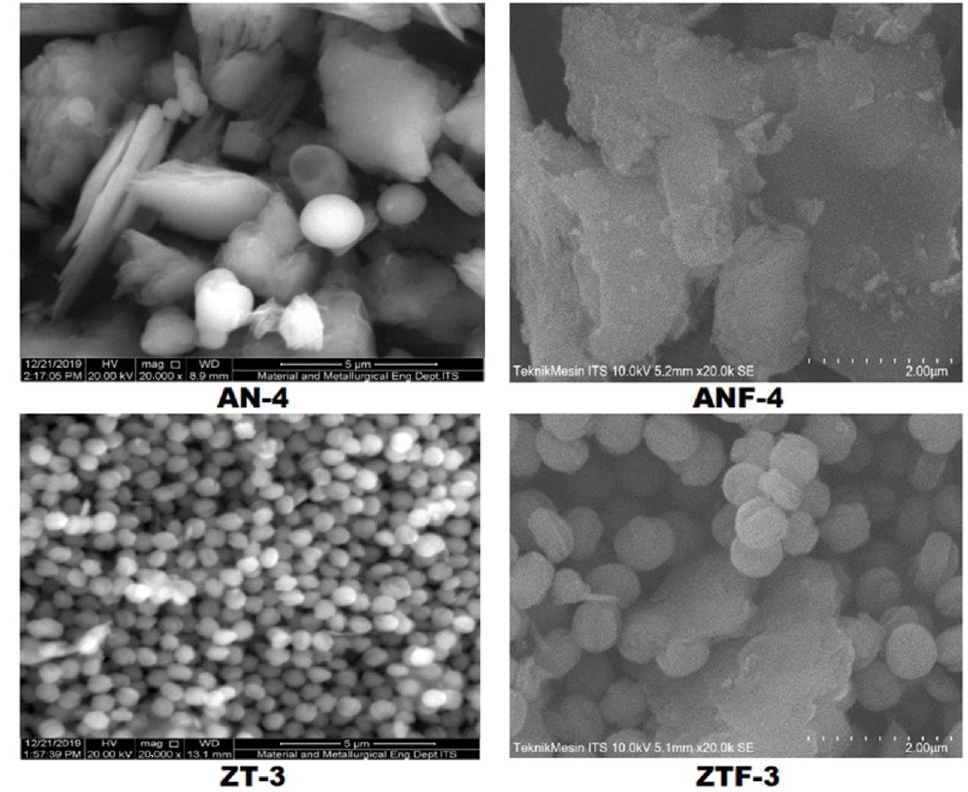
Figure 7. SEM images of aluminosilicates and ZSM-5 before and after Fe 3+ addition. The presence of amorphous materials can be indicated as aluminosilicate, while the presence of crystalline materials might be from quartz, iron metal, or other impurities [21].